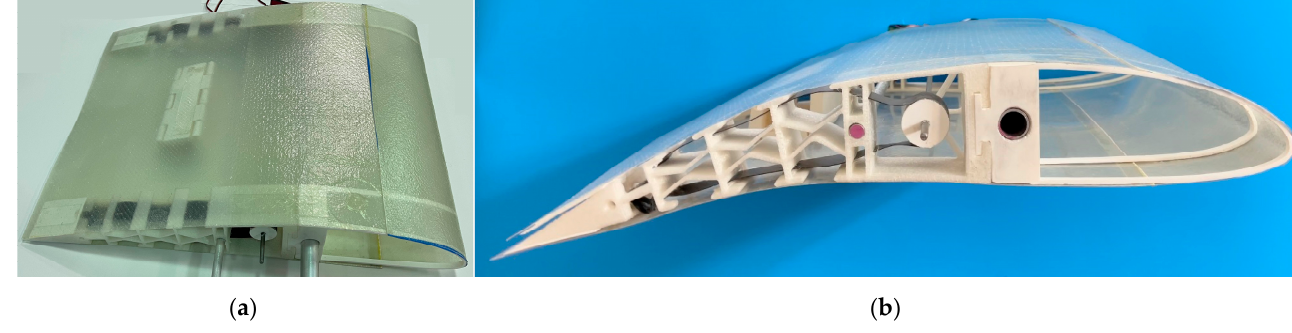
Figure 18. ( a ) assembled wing model; ( b ) cambered wing model.